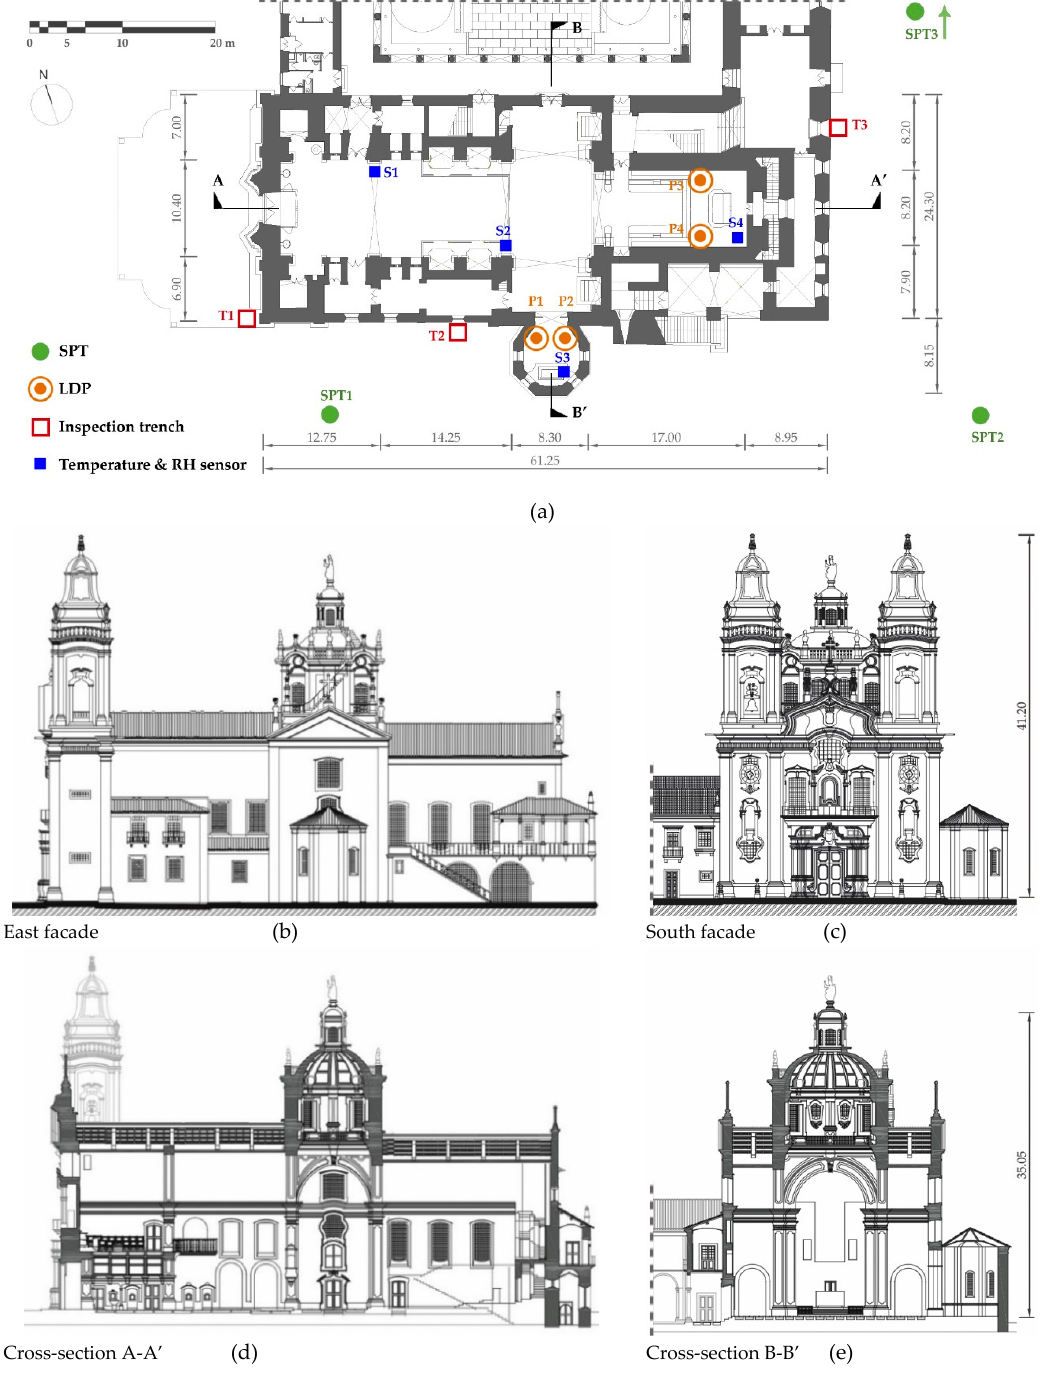
Figure 1. Architectural definition of the church of São Miguel de Refojos: ( a ) ground floor plan, ( b ) longitudinal elevation, ( c ) front elevation, ( d ) longitudinal cross-section, ( e ) transversal cross-section. Dimensions in m.